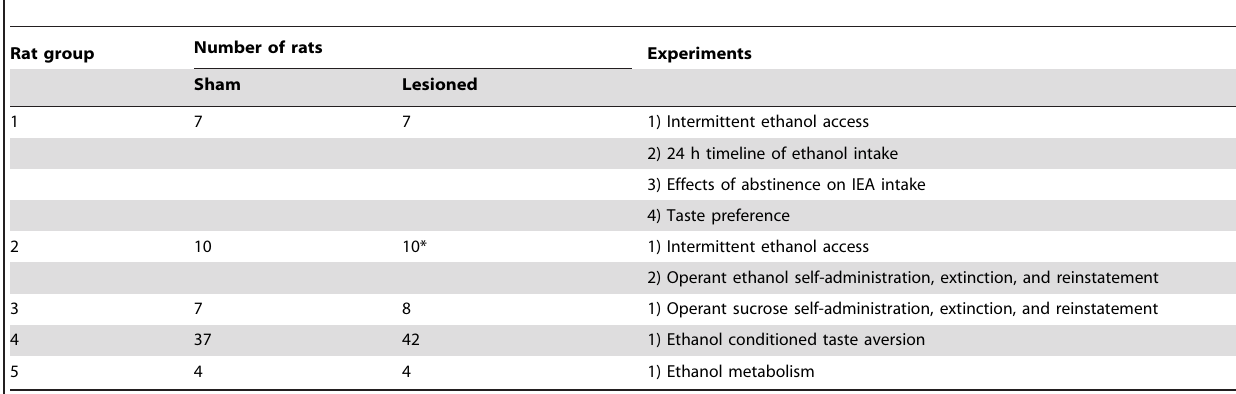
Table 1. Summary of experimental groups and timeline of procedures. Numbered experiments indicated the order in which experiments within each group were carried